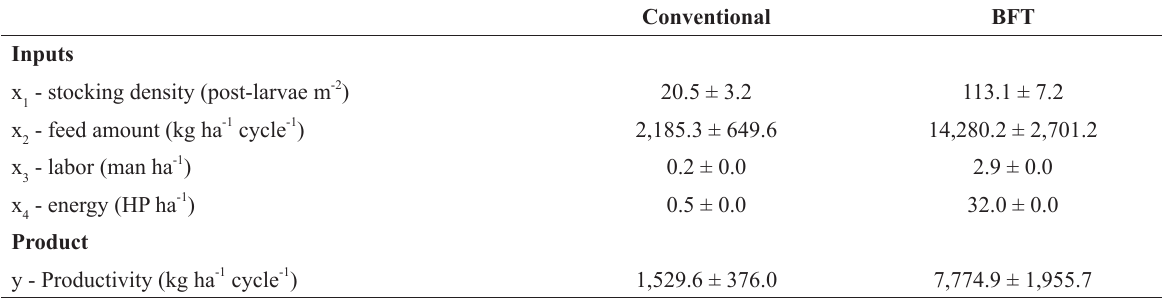
Means (± SD) of the variables used to estimate the general and technical efficiency of conventional and biofloc (BFT) systems in a farm located on the coast of Pernambuco,